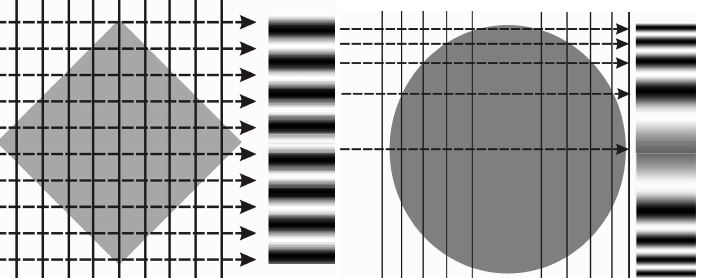
(cid:82) B . ds in a